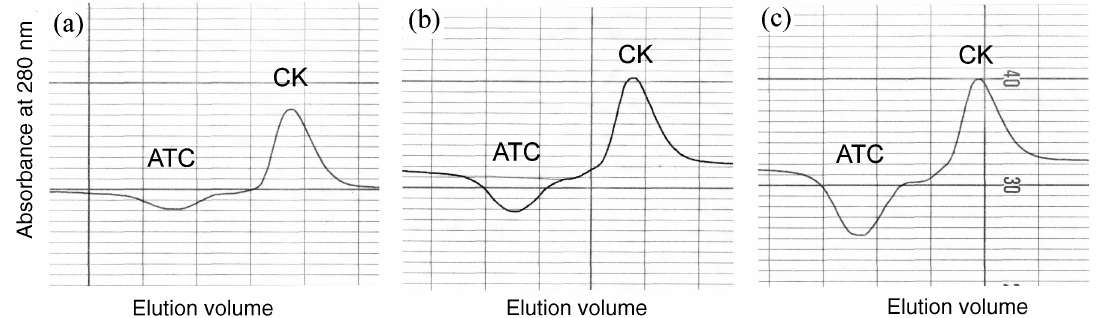
Figure 2. Hummel-Dreyer equilibrium gel filtration. A Superose 12 column was equilibrated with 20 mM Tris-HCl, pH 8.0, 100 mM NaCl buffer containing 1.7 µM aspartate carbamoyltransferase(ATC). Samples containing 5 µM carbamate kinase (CK) and various ATC concentrationswere applied to the column: (a) 1.7 µM ATC, (b) 0.9 µM ATC, and (c) no ATC.